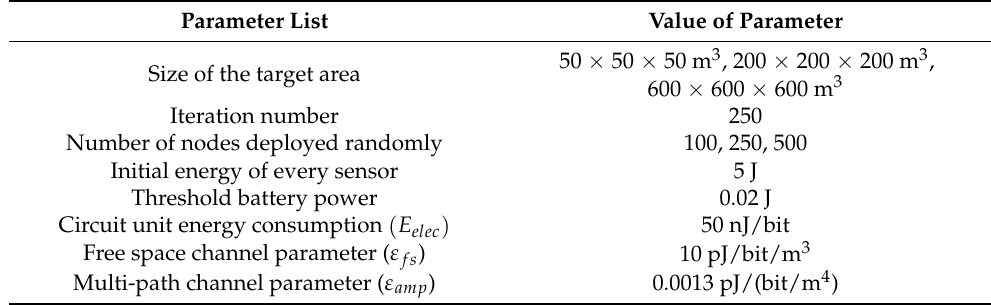
Table 2. Experimental